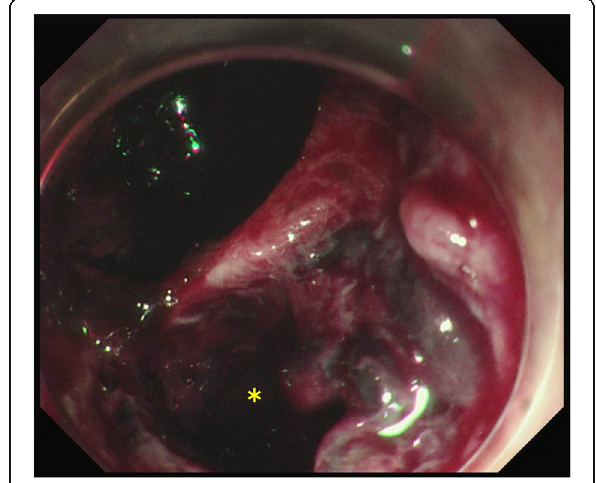
Fig. 1 Esophagogastroduodenoscopy (EGD) image on postoperative day 1, showing a mucosal laceration spanning from the esophagogastric junction to the gastric body, with a perforation in the center of the laceration (asterisk). The EGD probe could be easily passed through the perforation site